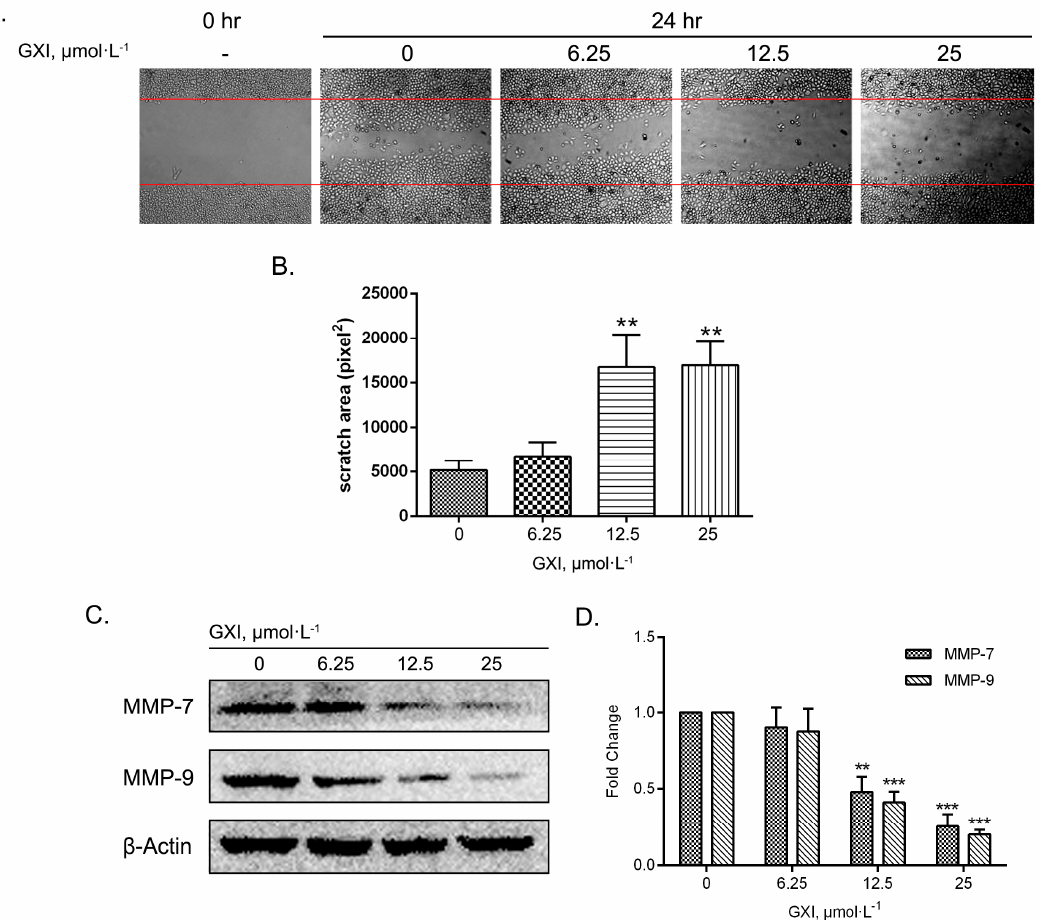
Figure 4. Inhibitory effects of GXI on cell migration in HepG2 cells. HepG2 cells treated with various doses of GXI for 24 h, and cell migration were tested by wound healing assay. ( A ) Cells migrating into the scratched area and photographed by inverted microscope in 100 × . ( B ) Calculated as pixel 2 of scratch area. Data represent mean ± SD. ** p < 0.01 compared with control. ( C ) Levels of MMP-7, MMP-9, and β -Actin detected by Western blotting. ( D ) Fold change of Western blotting. Data represent mean ± SD. ** p < 0.01, *** p < 0.001 compared with control.